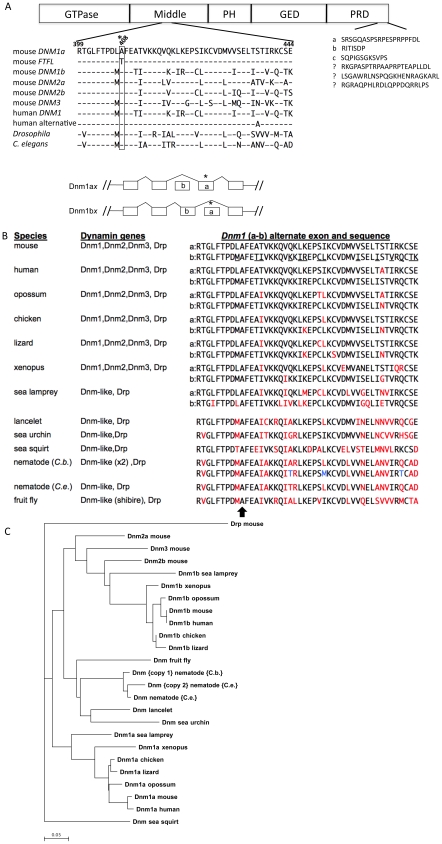
Conserved protein sequence alignment of Dynamins.(A) Conserved protein sequence alignment. The upper diagram shows DNM1 sequence conservation among various species and the location of the fitful mutation within the middle domain of the protein. The first splice region (amino acids 399–444) shows the location of the fitful mutation (*408) and the conservation within mammalian, fly and worm dynamins. Notice that the fly and worm orthologs do not have splice variants in this region. The second alternative splicing region is also shown at the end of the PRD domain. GTPase, GTPase domain; Middle, middle domain; PH, pleckstrin homology domain; GED, GTPase effector domain; PRD, proline rich domain. The bottom diagram depicts the mutually exclusive alternative splicing of the Dnm1a and Dnm1b isoforms. (B) Putative orthologues of mouse Dnm1, Dnm2, Dnm3 and Drp (dynamin related protein – official mouse gene symbol, Dnm1l) from different species. For simplicity, the same generic gene symbol is used for all; for simpler eukaryotes, the symbol Dnm refers to their orthologue(s) most like the mammalian Dnm1, Dnm2 or Dnm3. The known or predicted alternate sequences corresponding to mouse Dnm1 exon 10 are also shown. The underlined amino acid symbols show where mouse Dnm1b differs from Dnm1a. The arrow at the bottom shows the highly conserved alanine residue that is mutated to threonine in the mouse Dnm1Ftfl allele. Residues colored in red show amino acid substitutions with respect to mouse Dnm1; for nematode (C.b. - C. briggsae; C.e. – c.elegans), differences between the two Dnm peptides are shown in blue. Peptide sequences were obtained as follows: mouse Dnm1a: GenBank AAA37318, Dnm1b : GenBank EDL08539; human Dnm1a: GenBank AAA02804, Dnm1b: GenBank AAA02803; nematode [48] GenBank AAB72228; fruit fly (D. melanogaster) EMBL CAA42068. The remaining predicted sequences were obtained from analysis using the USCS Genome Browser and draft genome sequence assemblies from the following respective genome centers: chicken (G. gallus), sea lamprey (P. marinus) and nematode (C. briggsae) - Genome Sequencing Center, Washington University School of Medicine; opposum (M. domestica) and lizard (A. carolinensis), The Broad Institute; xenopus (X. tropicalis), lancelet (B. floridae), and sea squirt (C. intestinalis) - DoE Joint Genome Institute; sea urchin (S. purpuratus) - Baylor College of Medicine Human Genome Sequencing Center. The dynamin gene composition from sea lamprey was inferred from sequence alignment of draft 5.9-fold genome sequence (accessed via the UCSC browser - genome.ucsc.edu). When used as query, the respective mouse Dnm1, Dnm2 and Dnm3 peptide sequences corresponding to the assembly domain region each yielded significant alignments with only a single, approximately 20kb contig (Contig16000). This contig contained seven Dnm-like exons, with appropriate splice site recognition motifs, that was co-linear with mouse Dnm1 exons 8–13, including exons corresponding to Dnm1b (exon 10b) and Dnm1a (exon 10a) in the expected 5′-3′ arrangement. (C) Neighbor-joining best tree of dynamin peptides. Proportional number of differences is estimated at the bottom. Note the closer relationship between the two isoforms from sea lamprey and the respective Dnm1a and Dnm1b branches from more complex vertebrates. Also note the closer relationship between Dnm2 isoforms and invertebrate dynamin.